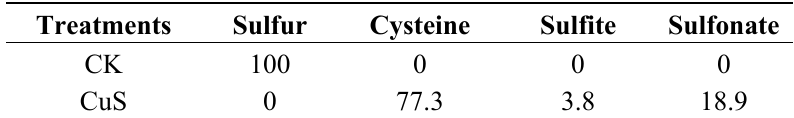
Table 2. Percentage of different S species in the biofilms as assessed by S K-edge XANES (atom%